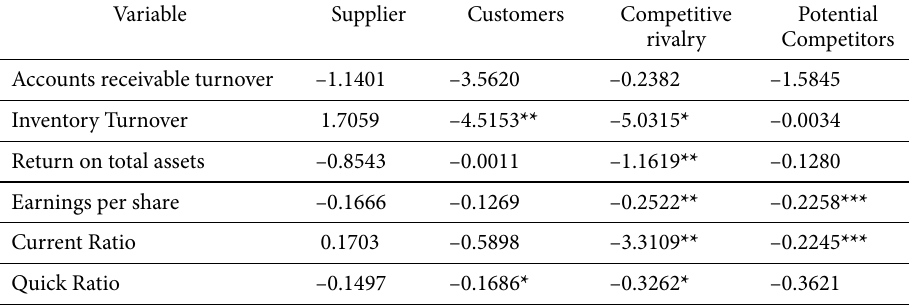
Table 3 . Cross-section analysis for patent infringement